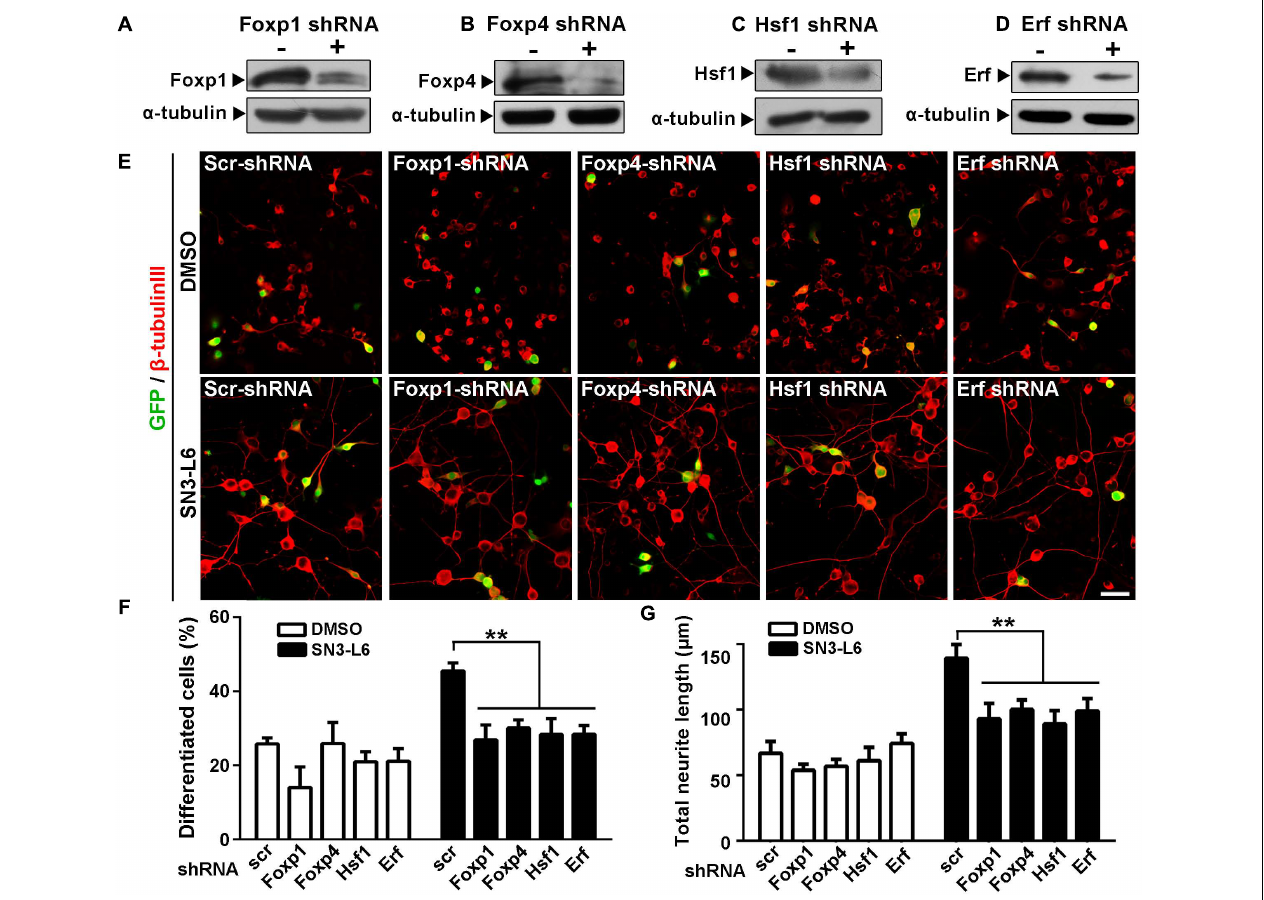
FIGURE 7 | Knockdown of Fox1, Foxp4, Hsf1, or Erf inhibits SN3-L6 effects on neuronal differentiation. (A–D) Neuro-2a Cells were transfected with scramble (scr) shRNA or shRNA of Foxp1, Foxp4, Hsf1, or Erf for 24 h. Western blot analysis shows that the knockdown of the individual transcription factors was successful. α -tubulin was used as a loading control. (E) Cells were co-transfected with GFP and scr-shRNA of individual shRNAs of Foxp1, Foxp4, Hsf1, or Erf. 24 h later, SN3-L6 was added to the cells to allow differentiation for 48 h. Neurites was visualized using β -tubulin III antibody (red). Transfected cells were indicated by GFP signals, Scale bar, 50 µ m. Differentiation rate (F) and total neurite length (G) were measured. ∗∗ P < 0.01, different shRNAs vs. scr-shRNA, mean ± SEM from three independent experiments. Statistical analysis was subjected to one-way ANOVA with Bonferroni multiple comparison